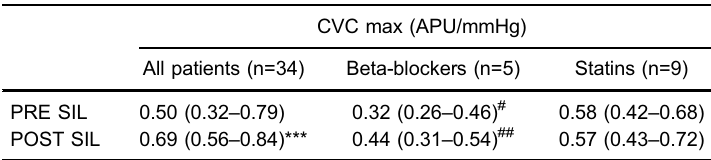
Table 4. Effects of penile acetylcholine iontophoresis on endothelium-dependent cutaneous microvascular conductance in hypertensive patients before (PRE SIL) and after (POST SIL) oral sildena fi l (100 mg) administration, according to pharma- cological